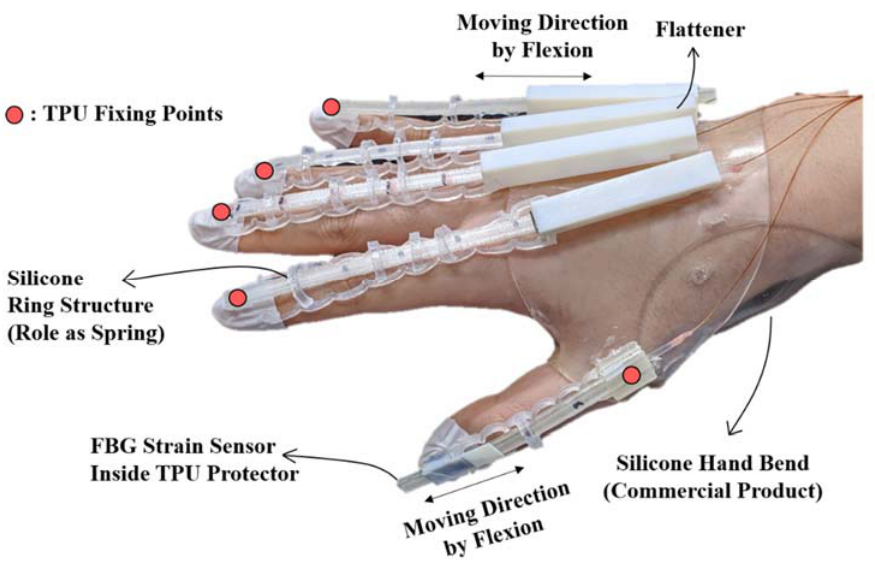
Sensors 2020 , 20 , x FOR PEER REVIEW Figure 2. Wearable hand module and its components. Figure 2. Wearable hand module and its components.